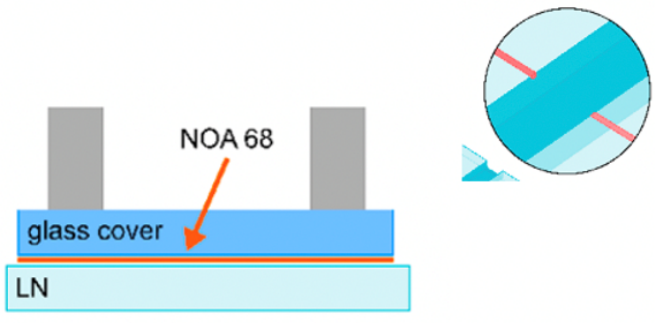
Figure 21. Low-cost Li:Ti waveguides for transmission detection. Reprinted from ref.